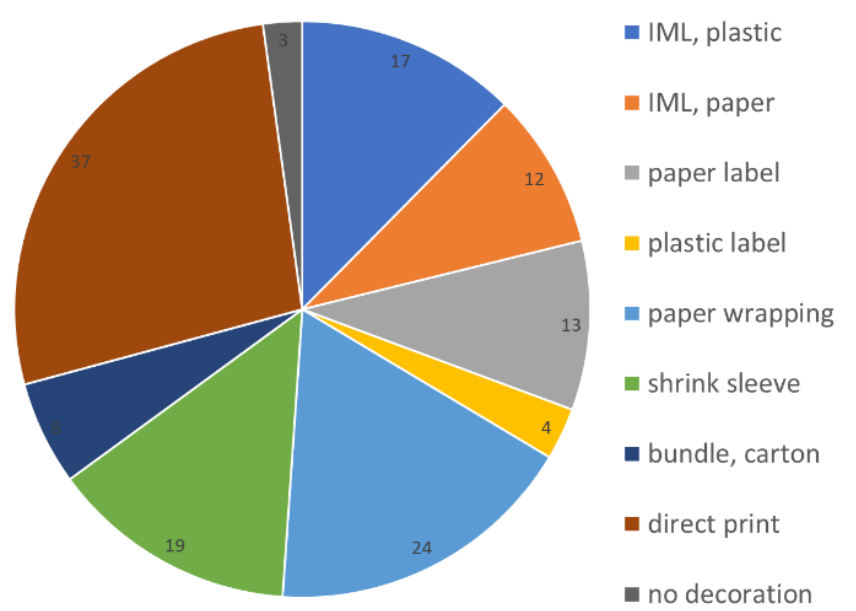
Figure 7. Decoration used for cups, without glass packaging; number: number of samples, IML: in- mould label, n = 137 .